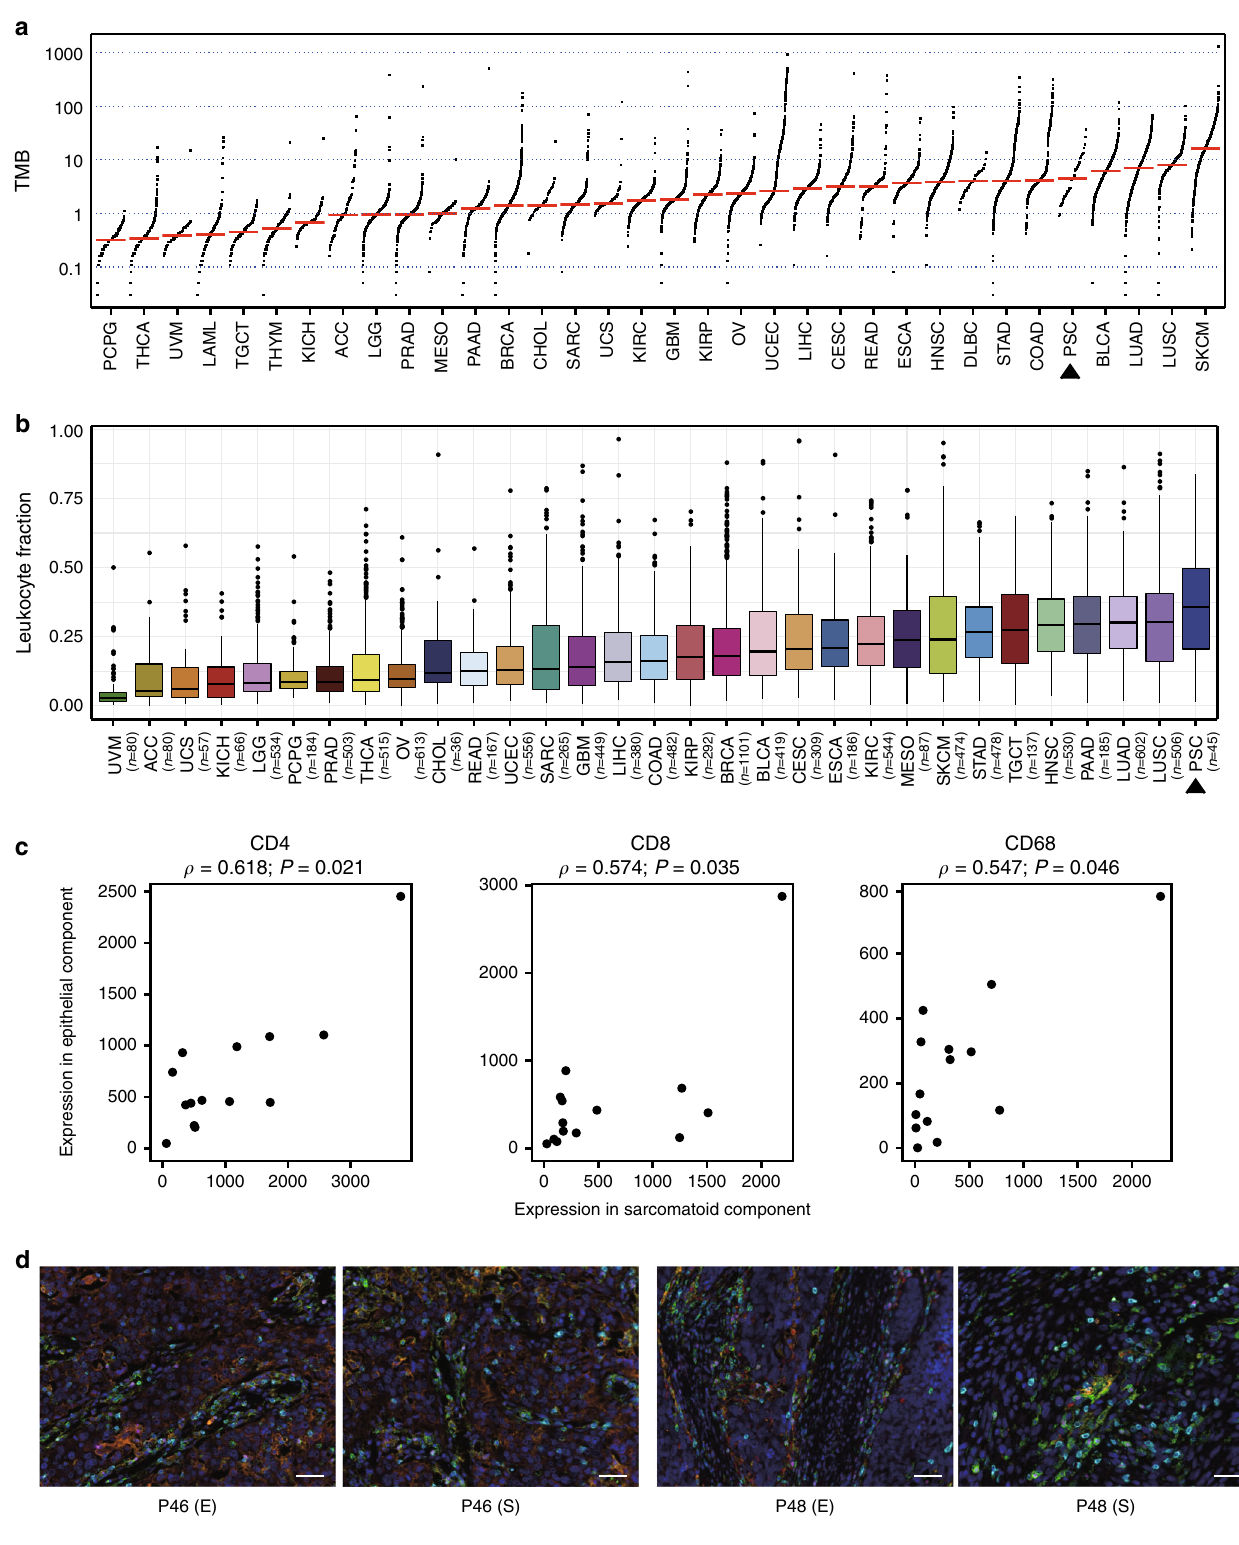
PSC. The high TMB and LF indicated that immunotherapy would be a good treatment option for patients with PSC. no signi fi cant differences in the expression of the fi ve